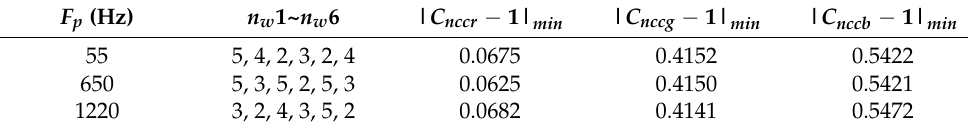
Table 2. The normalized cross-correlation when fine-tuning the number of crests.